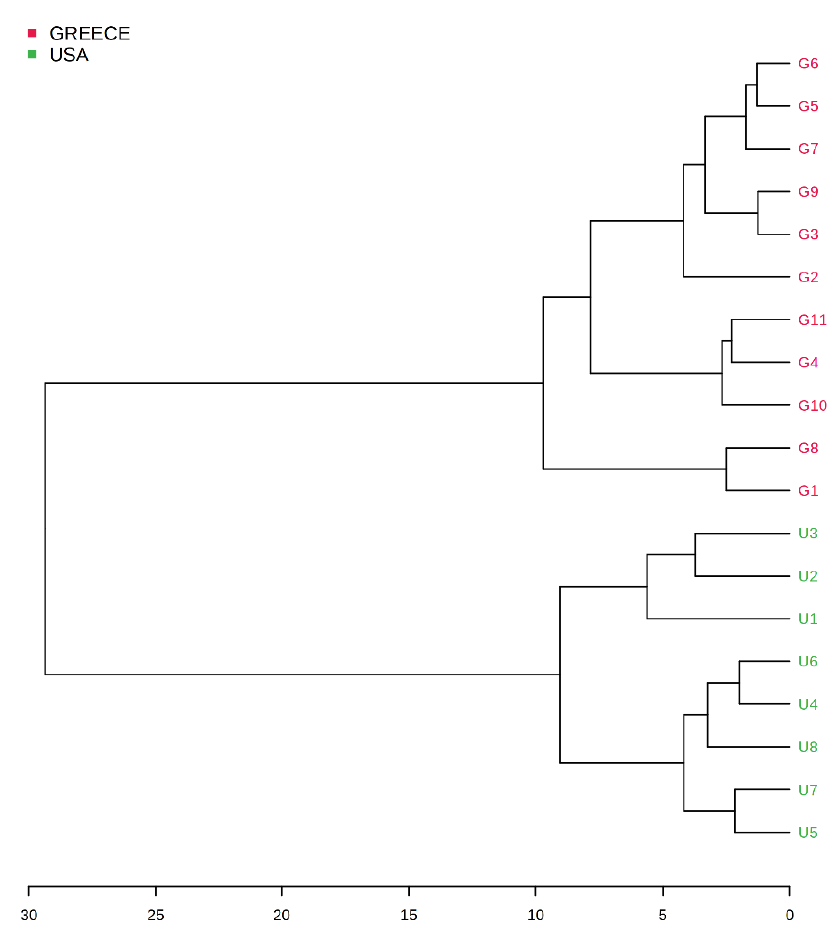
Figure 2. HCA dendrogram of Greek (G1–G11) and American (U1–U8) almonds’ clustering in two major groups.